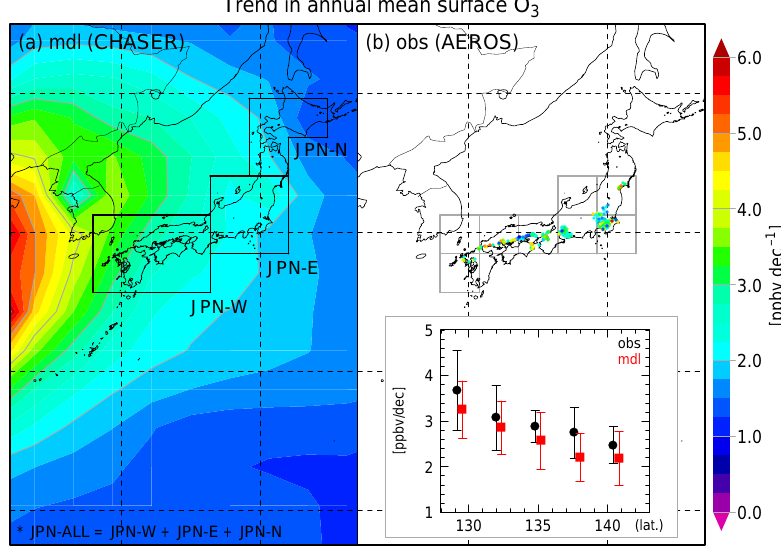
Figure 4. The linear trend in annual mean surface O 3 in 1980–2005 calculated from (a) model simulations and (b) observations at AEROS monitoring sites. The inset in (b) shows the longitudinal change in linear trends (black: AEROS observation; red: model) averaged within the model grids shown by gray rectangles. The error bars denote their 95% confidence intervals. The black-rimmed areas in (a) are the areas for averaging used in the figures from Fig. 6. Note that JPN-ALL is the sum of the JPN-W, JPN-E, and JPN-N areas and was used for the averaging in those